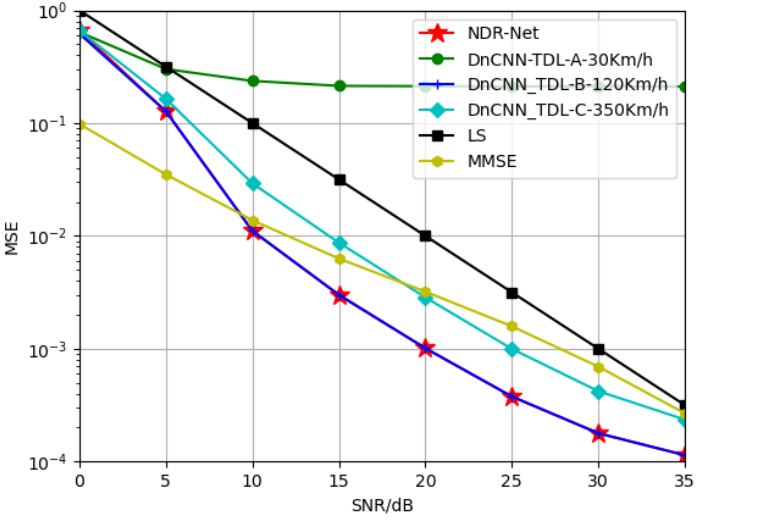
Figure 10. Generalization performance of different channel estimators when the training SNR = 15 dB and the testing channel is